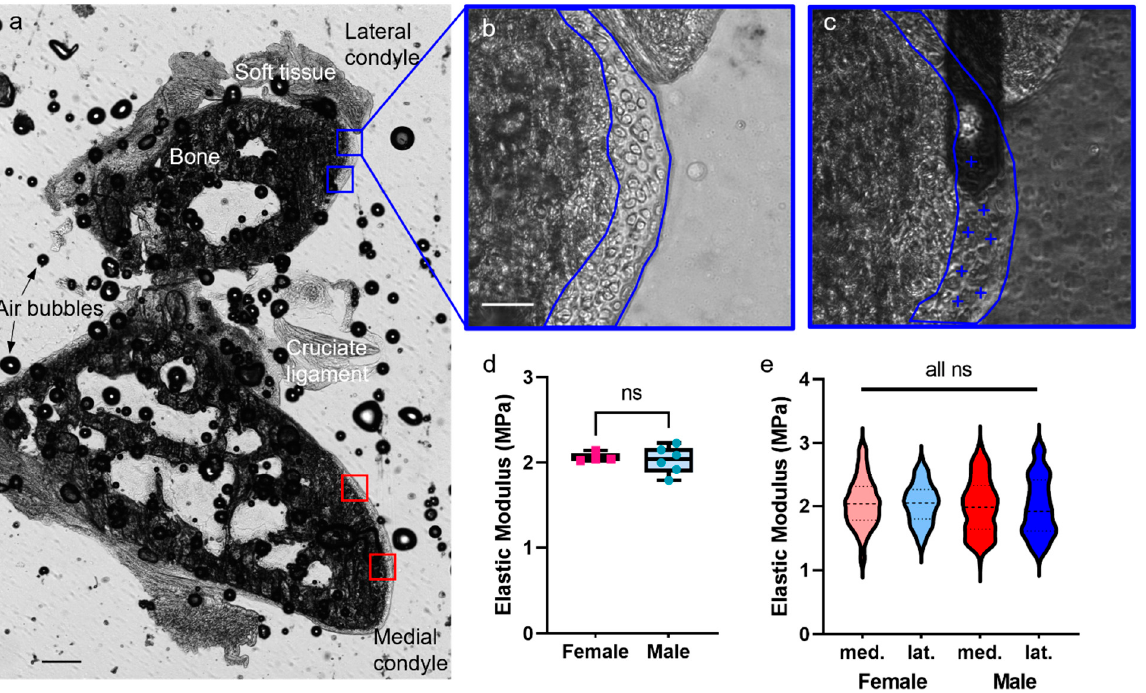
Figure 8. Sex does not affect elastic modulus of adult murine articular cartilage. ( a ) Section of a distal femur of a 12 week old C57BL/6J female mouse, showing four areas indented on medial and lateral condyles (red and blue boxes, respectively). A cruciate ligament is visible, as is the internal bone structure. Air bubbles between layers of tape are unavoidable; although visible, they do not affect sample section on surface. This image comprises two 4× images stitched together (aligned on PowerPoint and grouped), scale bar = 0.2 mm. ( b ) Example area of the articular cartilage on the lateral side. Scale bar = 40 µm. ( c ) An image showing indentations (blue plus signs) and visualization of AFM tip arm. ( d ) Comparison of articular cartilage elastic modulus from male (n = 6, blue circles) and female (n = 4, pink square) mice. ( e ) Violin plots of data on medial (red) and lateral (blue) articular cartilage from males and females (n = 3 each). Each point represents an average of 25 points within an area, and each sample was indented in two areas on both medial and lateral sides. Dashed lines indicate the median and quartiles. ns = non-significant ( p > 0.05).